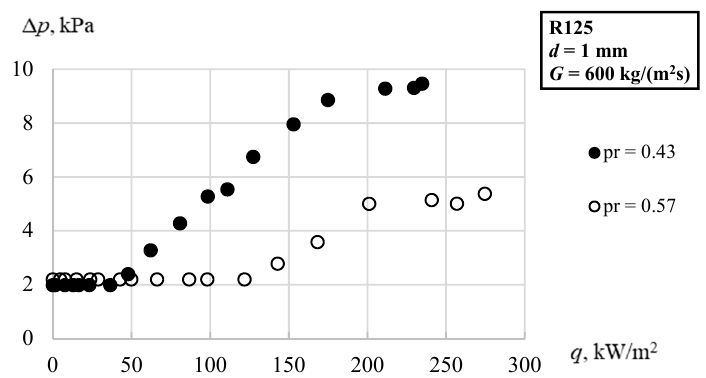
Figure 4. Pressure drop versus heat flux density at two values of reduced pressure.